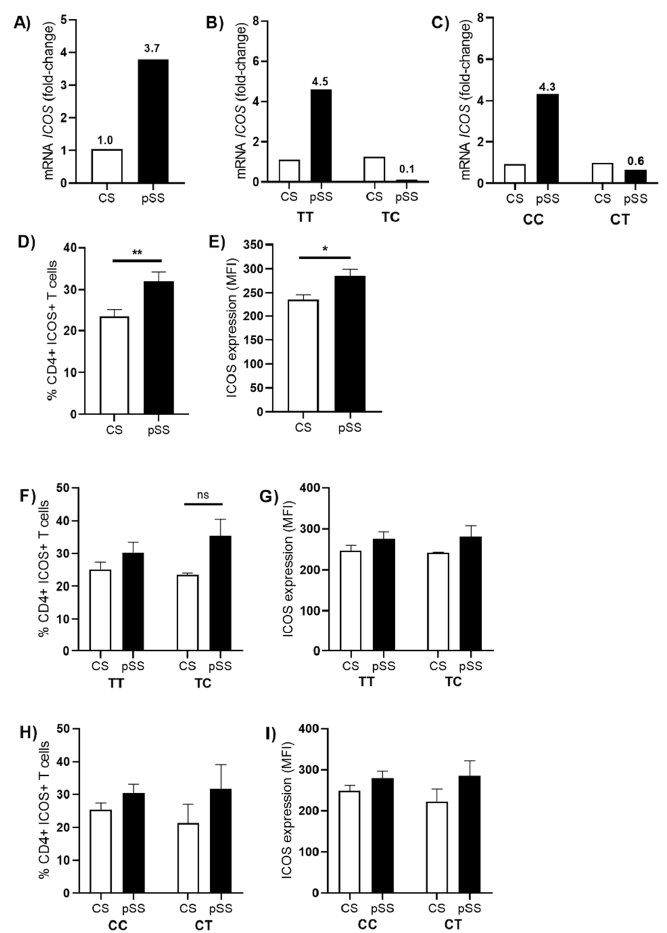
Figure 2. ICOS expression in primary Sjögren’s syndrome. ( A ) Comparison of ICOS expression in studied groups. Relative ICOS gene expression was determined by the 2 −ΔΔ Ct method using GAPDH as a reference gene. ( B ) Relative expression of ICOS according to the polymorphism (IVS1 + 173 T/C) and ( C ) (c.1624 C/T). ( D ) Analysis of T cells in peripheral blood in controls subjects and patients. ( E ) Representation of mean fluorescence intensity (MFI) for ICOS. ( F ) Percentage of CD3+ CD4+ ICOS+ T cells in IVS1 + 173 T/C carriers. ( G ) MFI for ICOS in IVS1 + 173 T/C carriers. ( H ) Percentage of CD3+ CD4+ ICOS+ T cells in c.1624 C/T carriers. ( I ) MFI for ICOS in c.1624 C/T carriers. The level of significance is represented by * p < 0.05, ** p < 0.01, Mann–Whitney U test, ns = not significative.